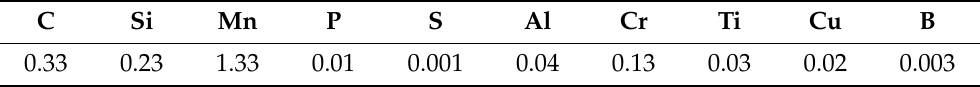
Table 1. Chemical composition of investigated manganese-boron steel 34MnB5 in